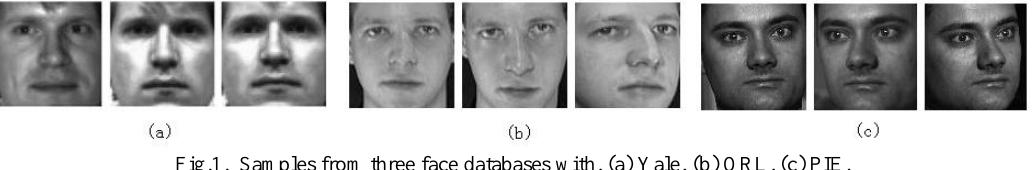
Fig.1. Samples from three face databases with, (a) Yale, (b) ORL, (c) PIE. Table 2. Optimal parameters of each